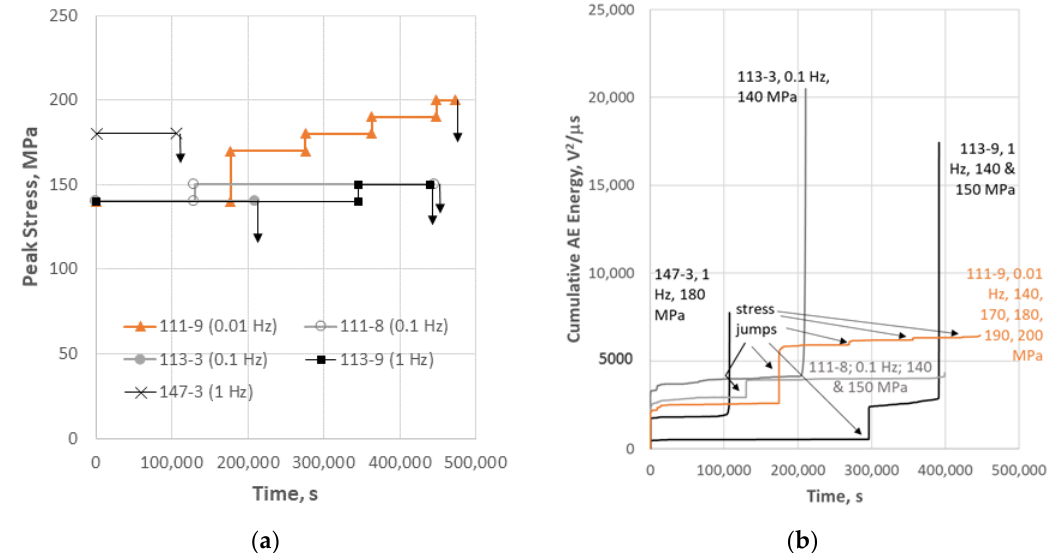
Figure 2. The history of stress condition and AE activity for the CMC specimens: ( a ) peak stress plotted versus time for R = 0.1 fatigue cycles where the downward arrow indicates failure; and ( b ) cumulative AE energy versus time for each specimen.